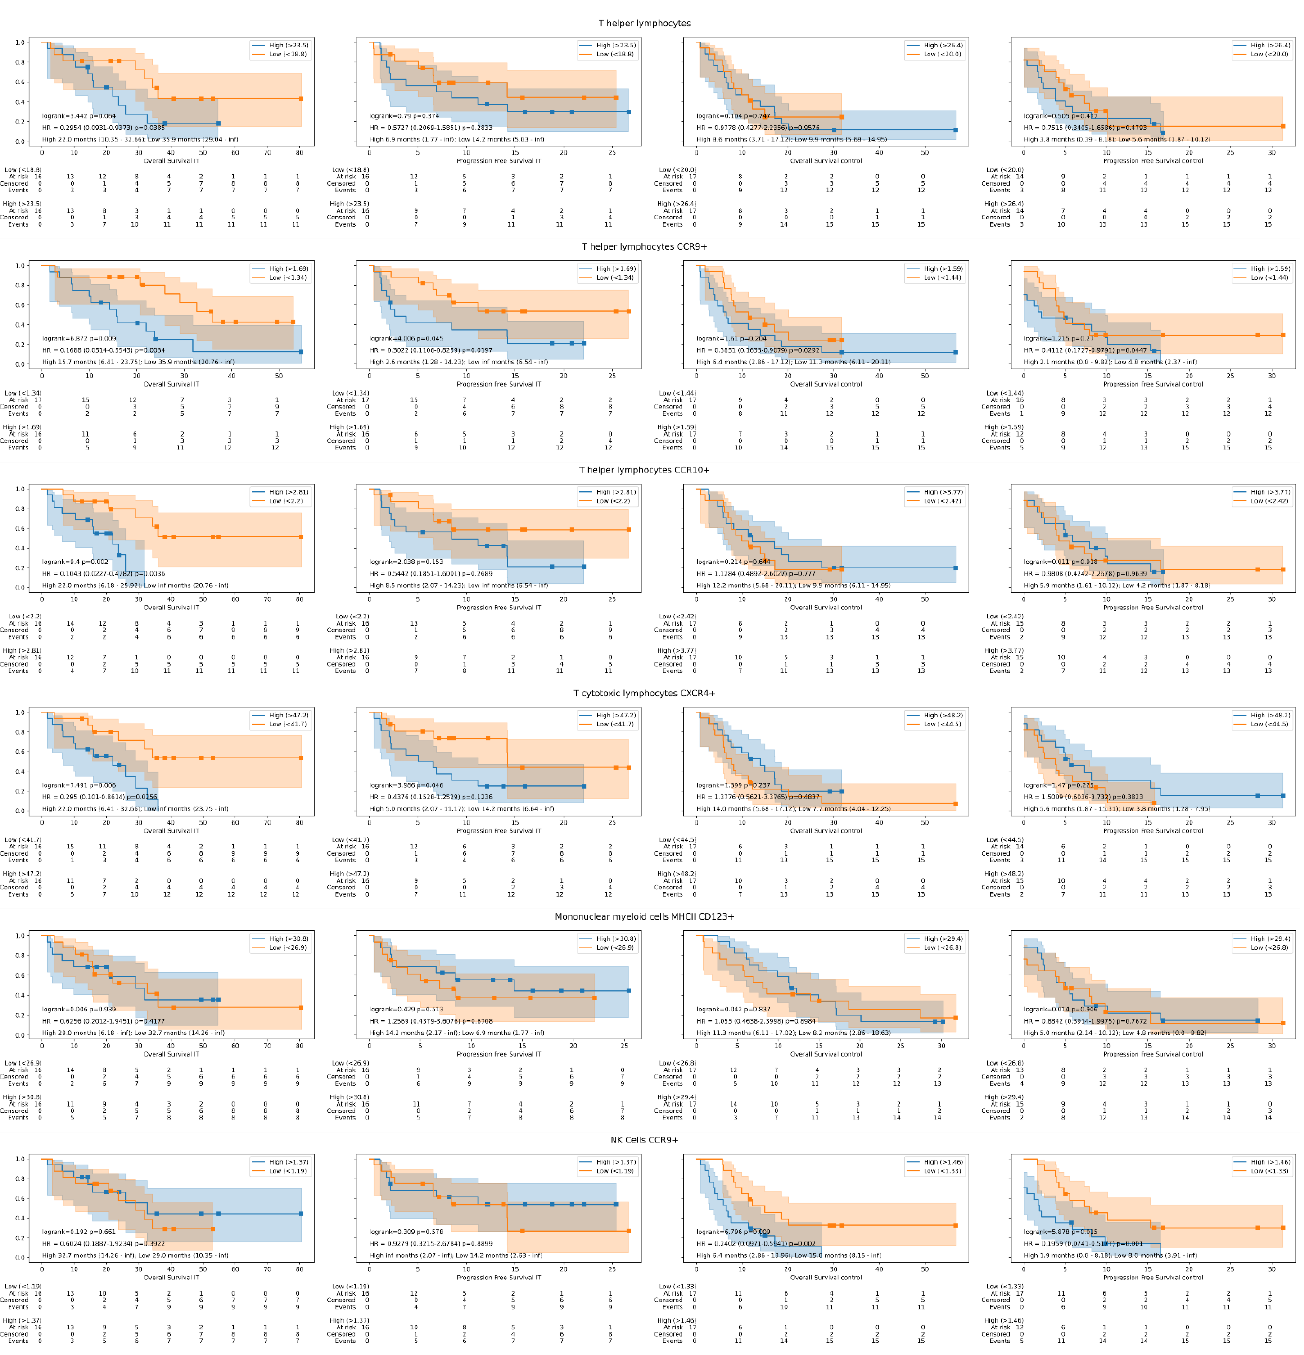
Figure 3. Overall survival and progression-free survival Kaplan – Meier curves in study and control groups according to the best immune biomarkers detected. The Kaplan-Meier curves show the differences in survival according the high or low expression of each peripheral blood mononuclear cell subpopulation studied in immunotherapy treated (IT) group and in control group treated with non-immunotherapy drugs. In addition, the log-rank test, multivariate cox regression models, and the median progression-free and overall survival values with their range are reflected. Neither cell subset detected as a possible predictive biomarker in NSCLC (study group) was correlated with survival in the control